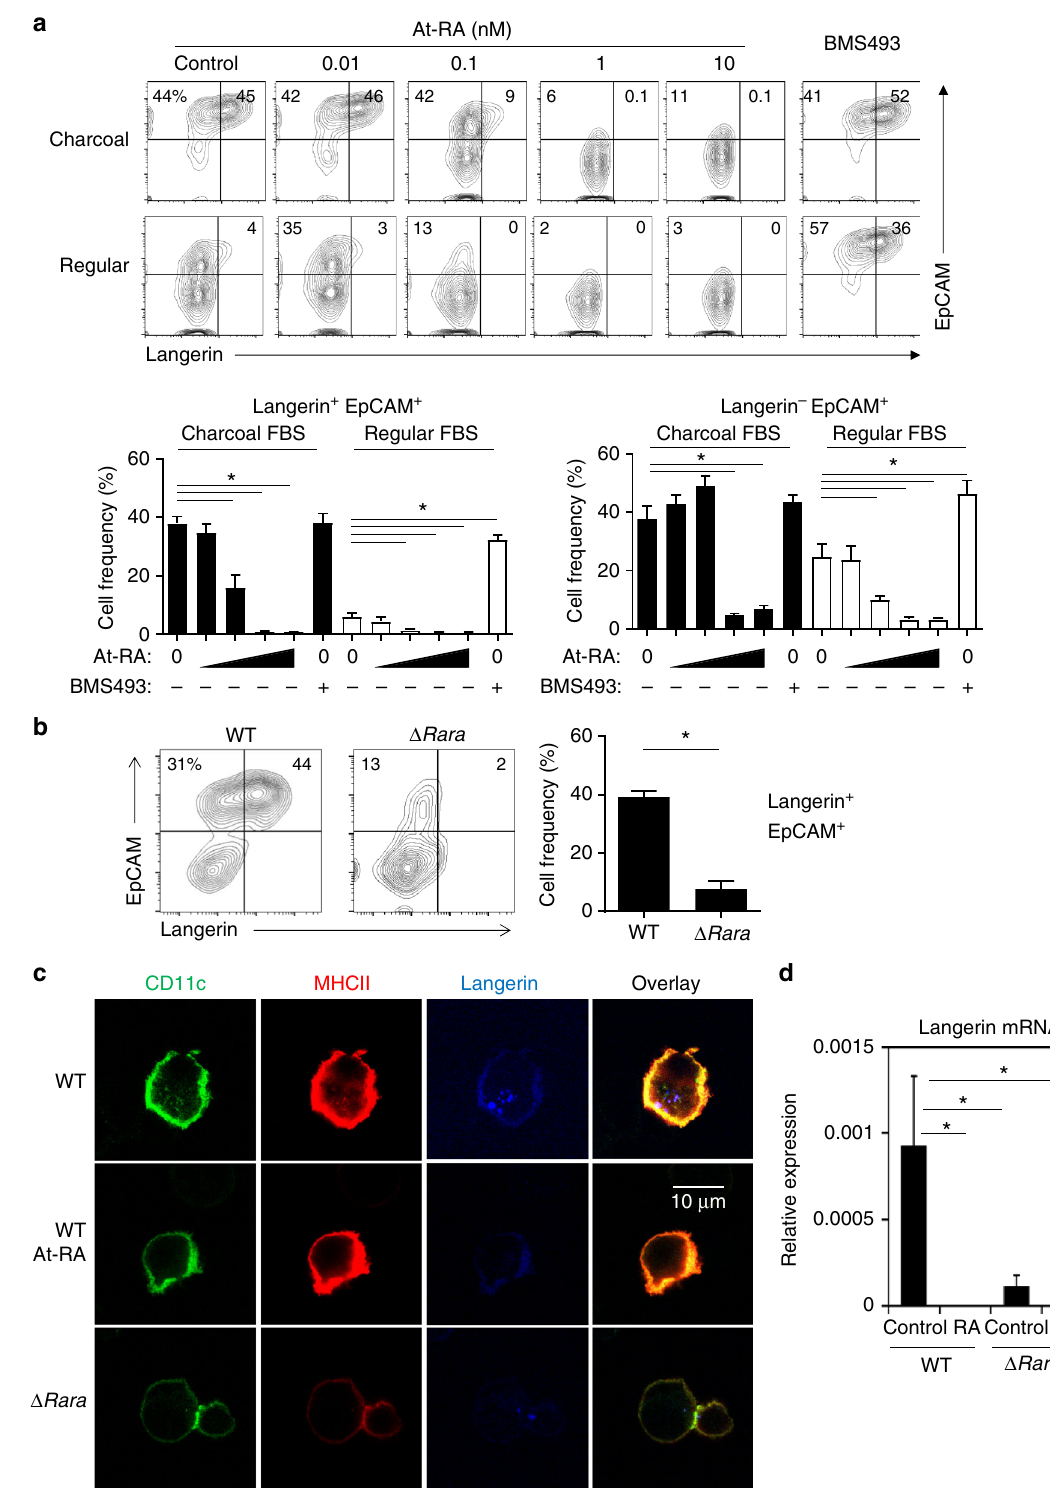
Fig. 3 RA negatively regulates LC development. a RA suppresses langerin + cell (BM-LC) generation in vitro, while the RAR antagonist BMS493 enhanced BM-LC generation. For BM-LC culture, BM cells were cultured in GM-CSF and TGF β 1 for 3 days in the presence of At-RA (0.01, 0.1, 1 and 10 nM) or BMS493 (100 nM) in media containing charcoal-treated or regular FBS. Frequencies of indicated CD11c + cells are shown in graphs. b Defective BM-LC generation from BM cells of Δ Rara CD11c mice. BM cells were cultured in a medium containing charcoal-treated FBS. c Confocal fl uorescent microscopy of langerin expression by CD11c + BM cells cultured in the LC-inducing condition without and with RA (1 nM). d Expression of Rara mRNA by CD11c + BM cells cultured in the LC-induction condition without or with RA (1 nM). Normalized values for a housekeeping gene (GAPDH) are shown. Representative and combined data ( n = 3 – 8) from at least 3 experiments are shown. *Signi fi cant differences from control or between indicated groups by one-way ANOVA with Bonferroni multiple comparisons ( a ) or Mann – Whitney U test ( p < 0.05, unpaired, 2-sided, b , d ). Error bars are de fi ned as